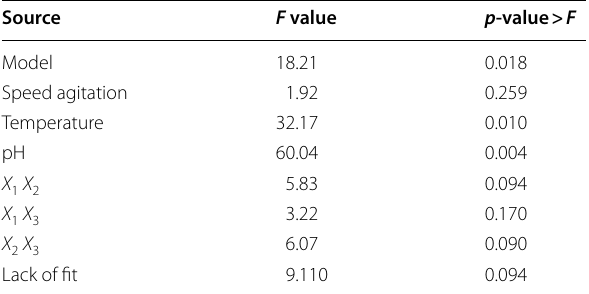
Table 3 Analysis of variance (ANOVA) for β-galactosidase